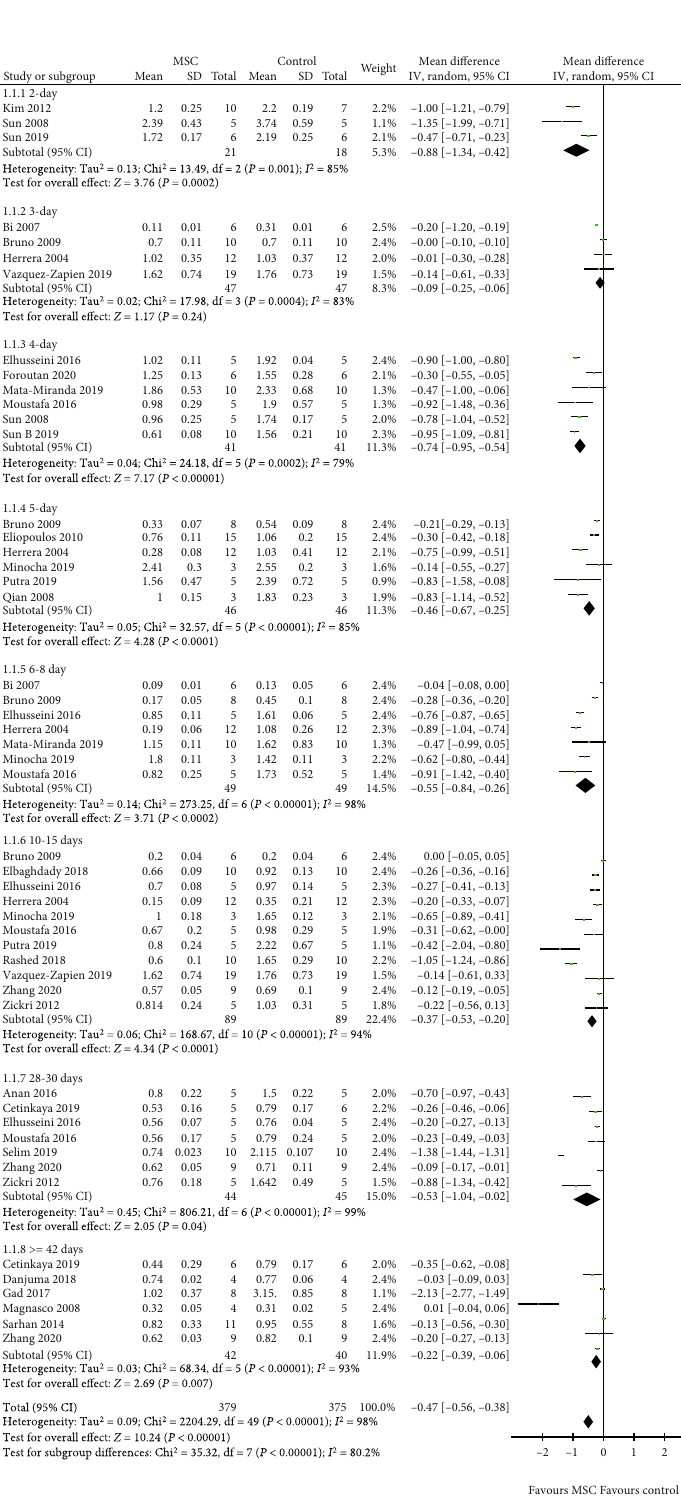
Figure 3: E ff ect of MSC on